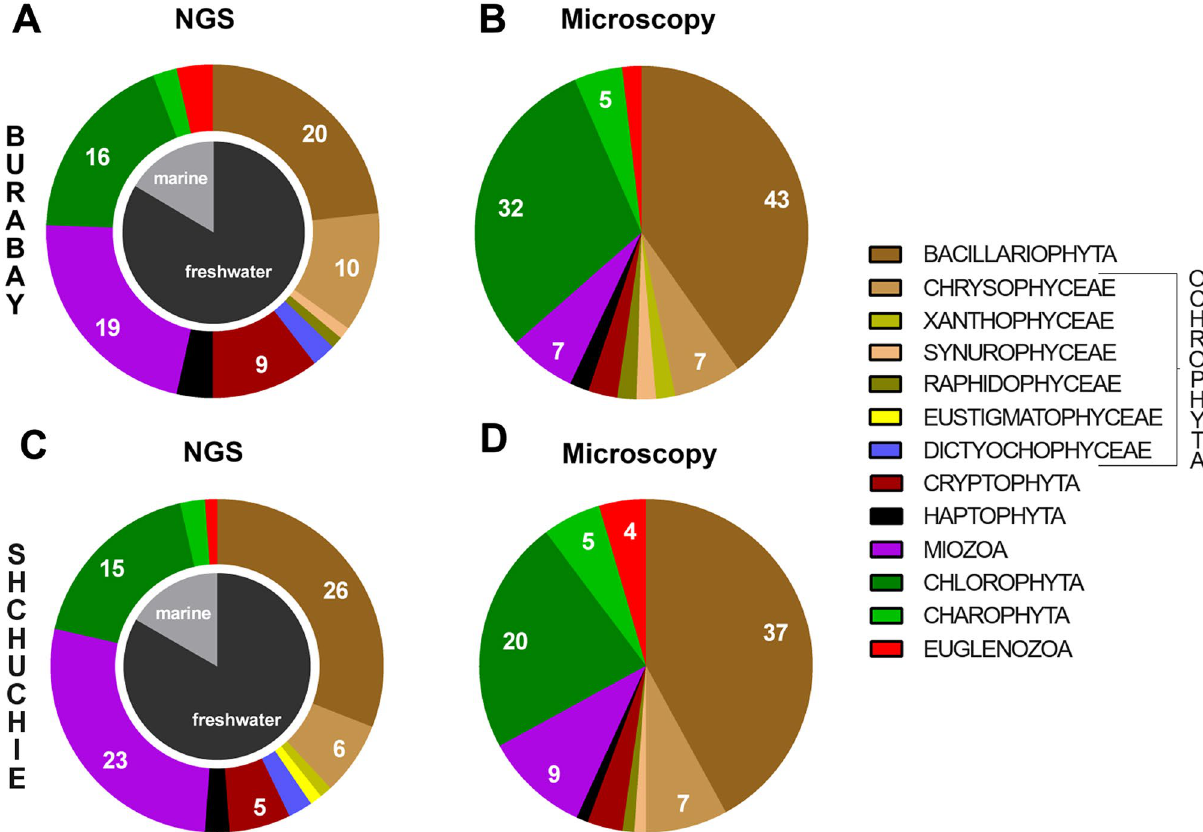
Figure 4. Contribution of different taxonomic groups in genera composition of eukaryotic phytoplankton in Lakes Burabay ( A,B ) and Shchuchie ( C,D ) based on microscopy ( B,D ) and molecular ( A,C ) approaches. Spearman correlative analysis, linear regression and curve estimation (Suppl. File 1) indicated positive correlation between plankton genera distribution defined by microscopic and NGS